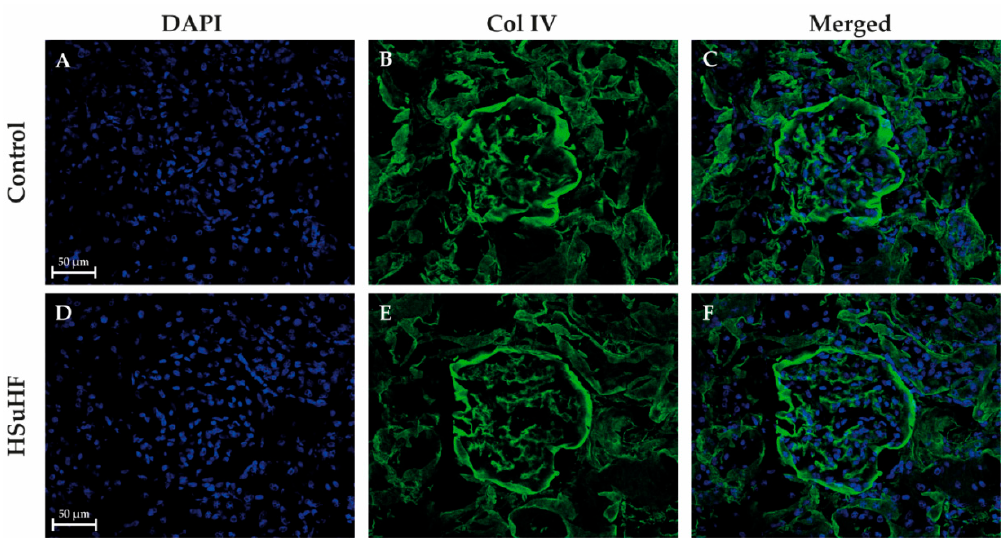
Figure 3. Representative confocal images of immunolabelling for collagen IV (green: B and E), DAPI (blue: A and D), as well as merge (C and F) in the Control and HSuHF-treated rats ( n = 8 per group).